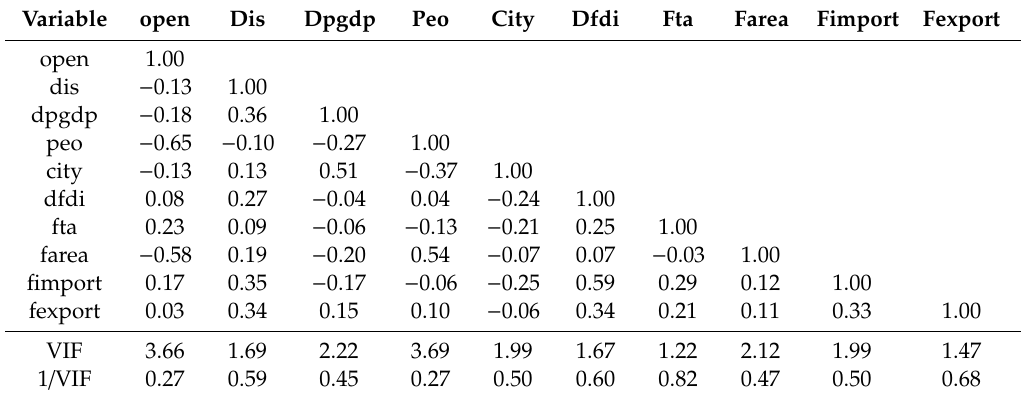
Table 4. Multicollinearity test